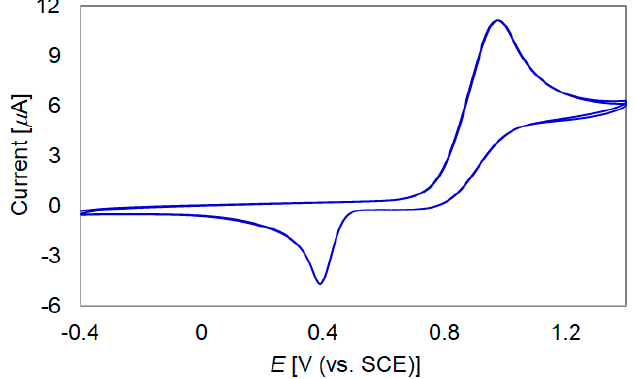
Figure 7. Cyclic voltammogram of 1 in CH 2 Cl 2 containing 0.1 M Bu 4 NBF 4 as a supporting electrolyte (scan rate 100 mV s − 1 , Pt electrode).